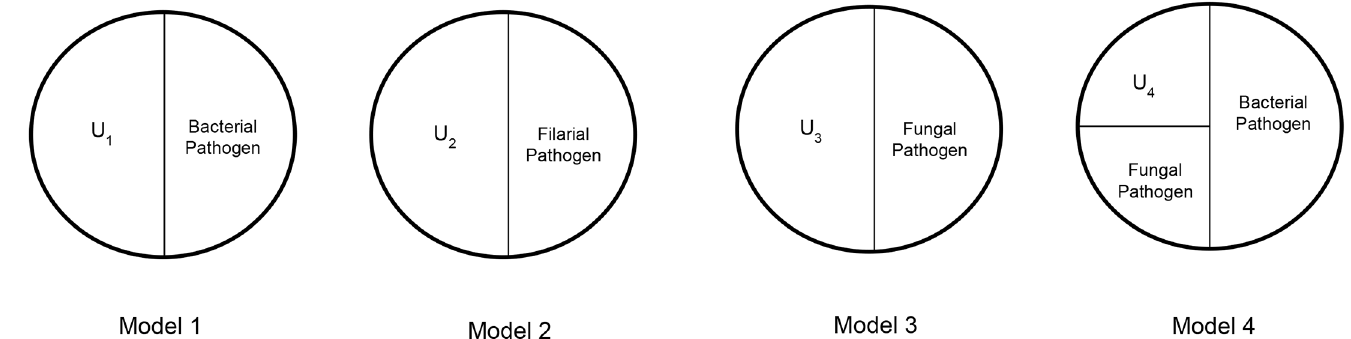
Fig 1. Sufficient component cause models (SCCMs) of ADL episodes among patients with lymphatic filariasis. Each SCCM represents a sufficient cause, which contains a minimal set of conditions that result in the outcome of interest. Each piece of the pie represents a risk factor for the outcome and is defined as a component cause. Each pie is defined as a sufficient